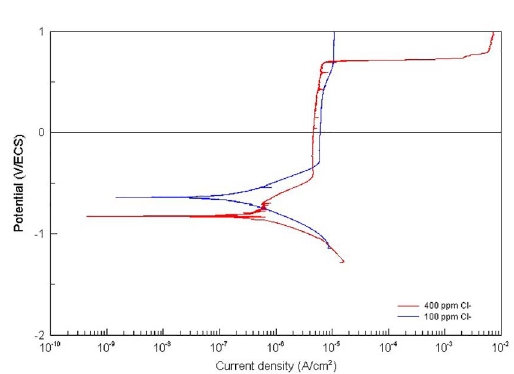
Figure 9. Potentiodynamic polarization curves for AA7075-T73 alloy in low (100 ppm) and high (400 ppm) chloride concentration machining